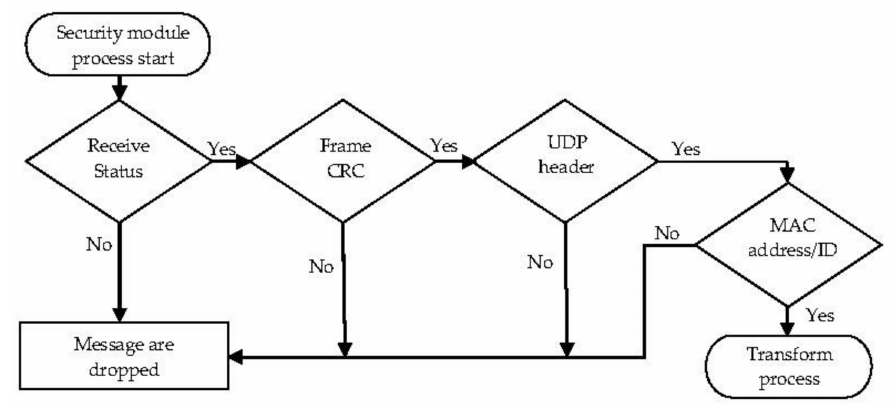
Figure 7. Flow chart of the security module.